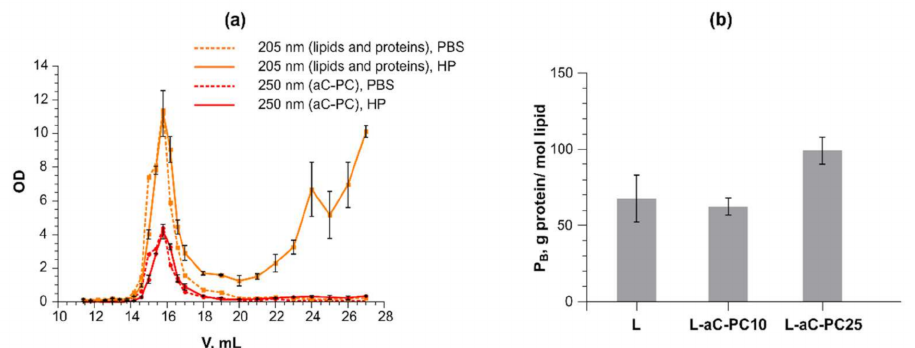
Figure 3. ( a ) Gel permeation chromatography elution profiles obtained for the L-aC-PC10 liposomes incubated with PBS (dashed lines) or 50% human plasma (HP; solid lines) through measurement of absorption at 205 (lipids and protein; orange) and 250 nm (aC-PC; red) in the fractions. ( b ) Protein binding values obtained for the joint liposome peak fractions upon concentrating via